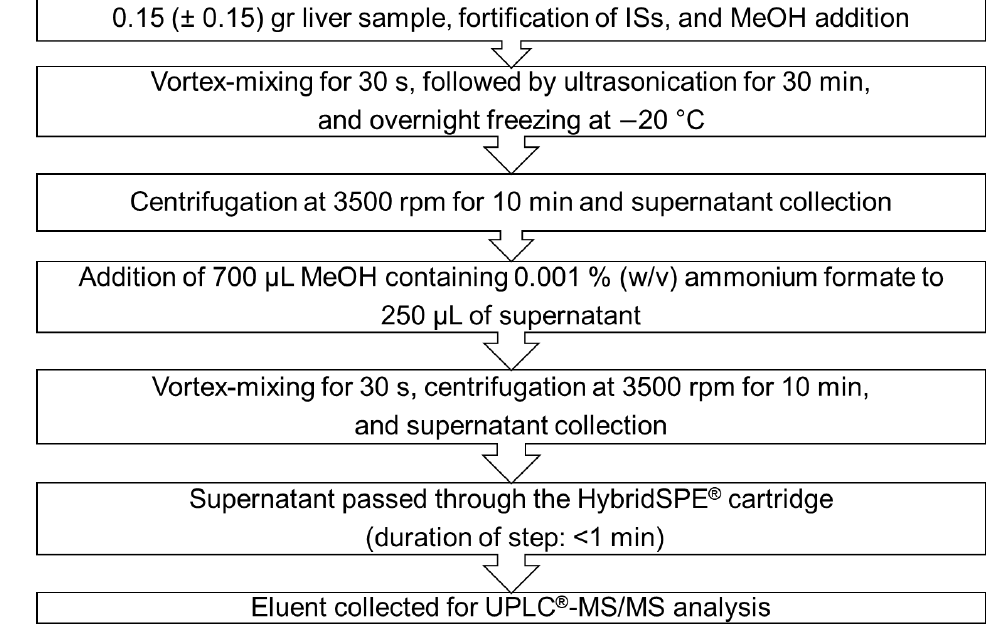
Figure 1. Sample preparation workflow.